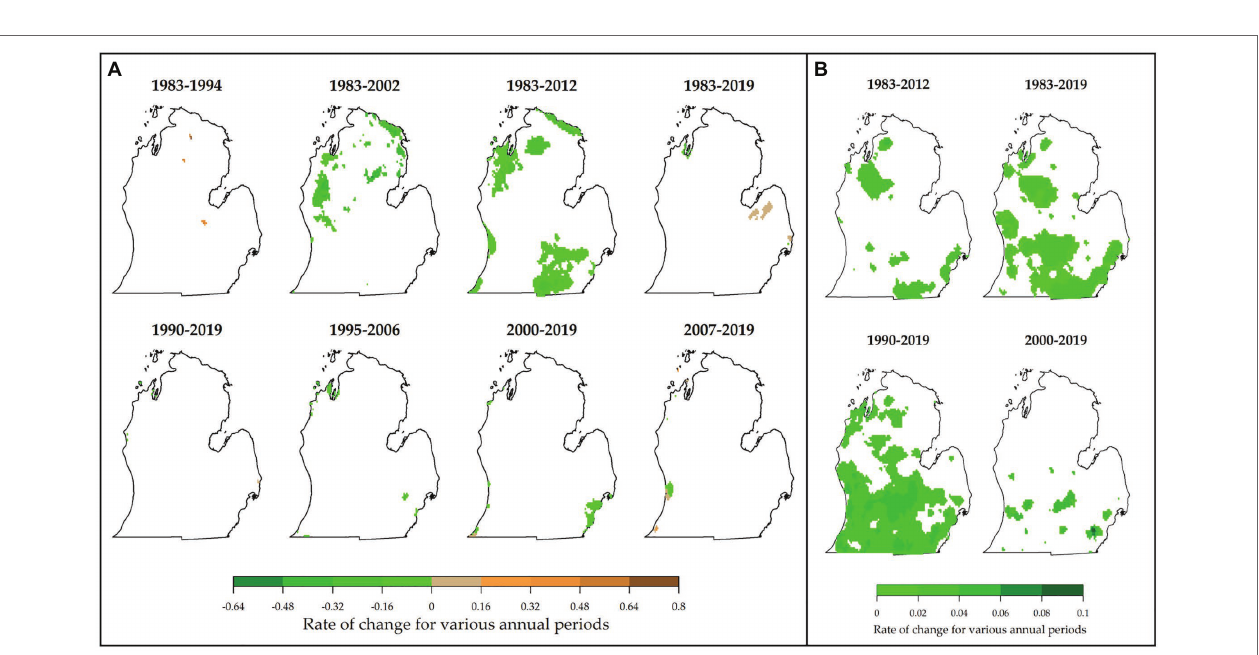
FIGURE 6 | Magnitude of change in the annual frequency of cold days (FCDs; days per year; A ) and growing season temperatures (GSTs; B ). Locations of persistenly changed FCDs and GSTs are